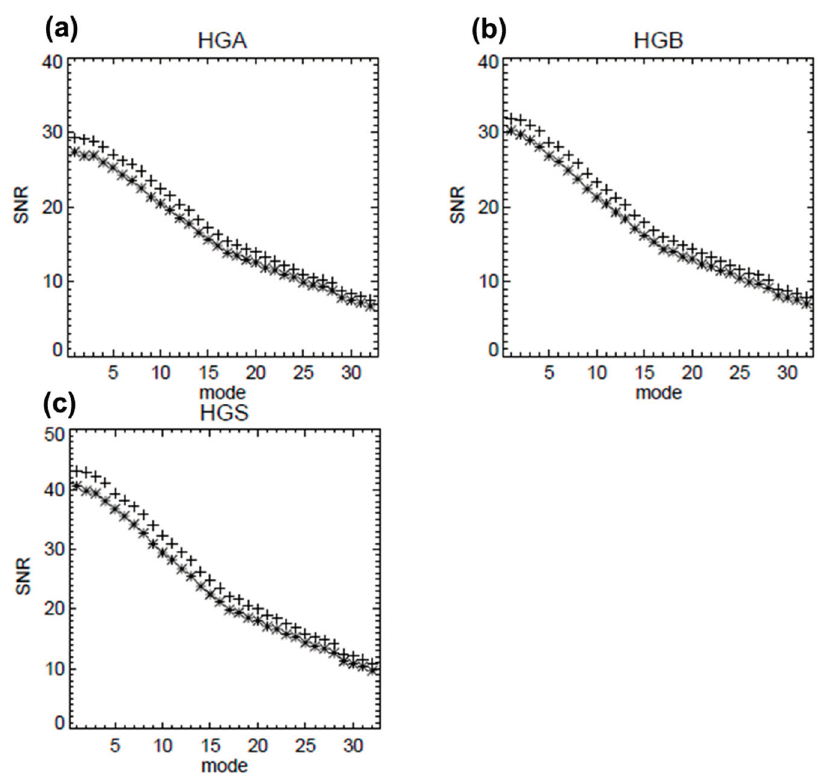
Figure 11. Detector averaged SNR computed from SV view data for February 2012 (+) and August 2014 (*). HGA, HGB and HGS are shown from ( a ) to ( c ). The x-axis indicates the DNB aggregation modes, where Modes 1 to 32 are used to collect data from nadir to the edge of the EV scan (see Figure